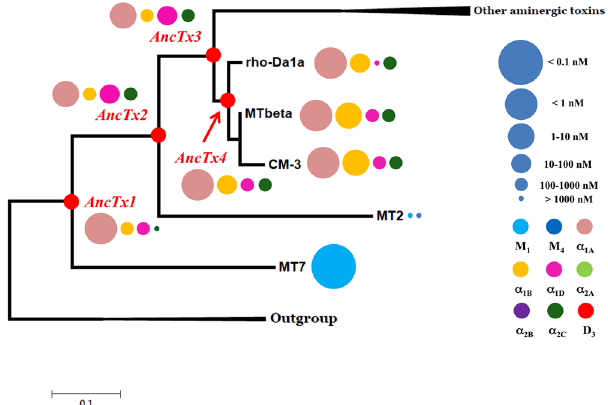
Figure 5. Maximum likelihood tree and associated function of the aminergic toxins from ρ -Da1a evolutionary pathway. Bootstraps value higher than 50% are shown. Toxin’s functions are illustrated by circles identifying the receptor targeted (color) and the corresponding K i value (circle size), as described in the right legend, at the right side of each toxin name.